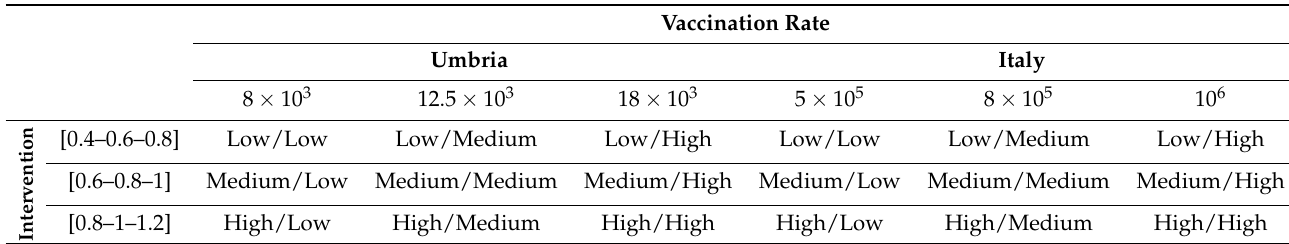
Table 2. Future scenarios simulated for Umbria and Italy through variation of the vaccination rate and of intervention parameters. The three values on the first column represent the increase of transmission parameters on 26 April, 24 May, and 21 June 2021, respectively. The first row indicates the number of first doses of vaccine per